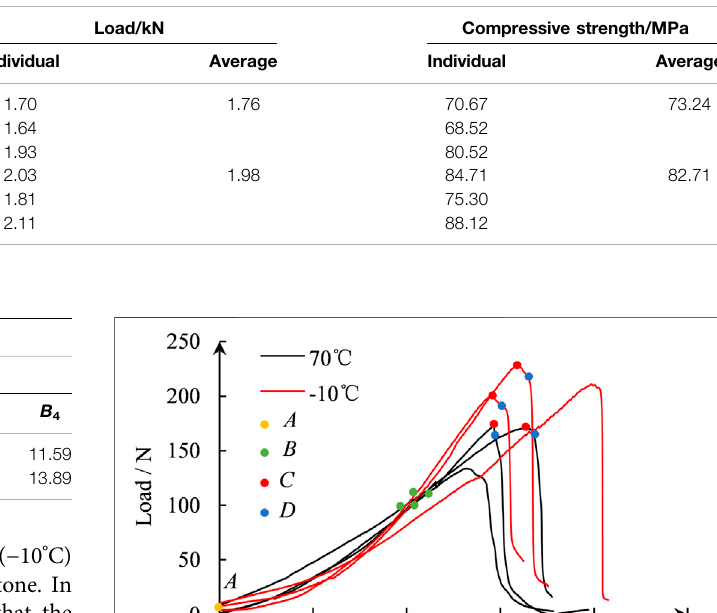
TABLE 2 | Testing values of compressive strength.